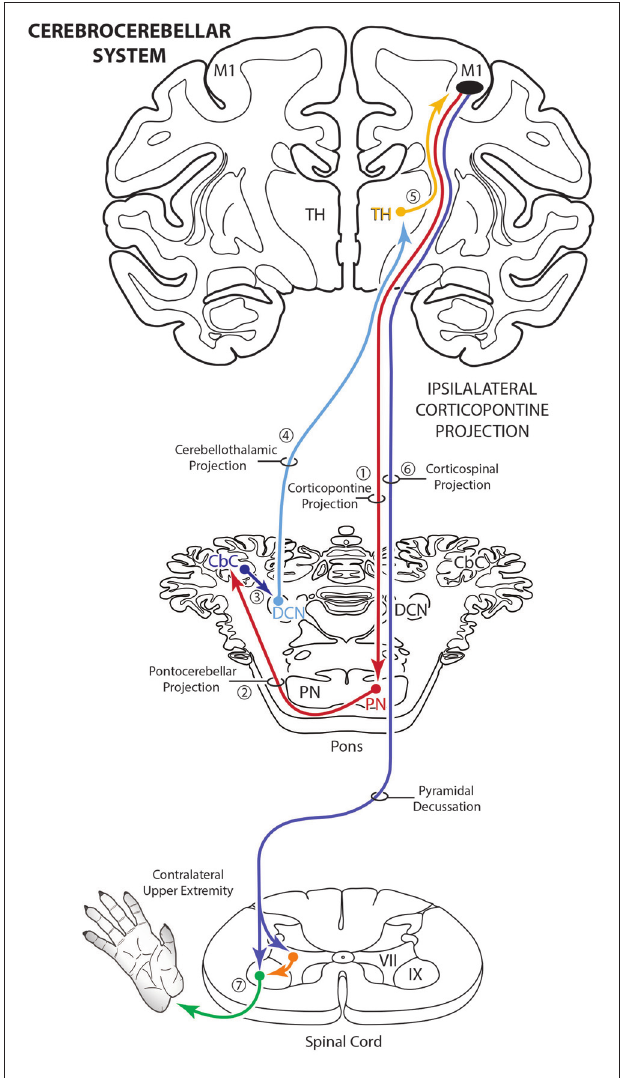
FIGURE 1 | Schematic diagram illustrating the classical cerebrocebellar circuit originating from the primary motor cortex (M1). The sequential stages of the circuit are numbered starting with the powerful descending ipsilateral corticopontine projection (iCPP) to the pontine nuclei (PN) (1). Note that the PN project to the contralateral cerebellar cortex (CbC) (2) and the major cerebellar output from the deep cerebellar nuclei (DCN) ascends to innervate the contralateral thalamus (TH) (4). The thalamus then projects back to the ipsilateral motor cortex (5). The final effect of this cerebrocebellar circuit is on the contralateral upper extremity, via the nearly exclusive contralateral M1 corticospinal projection (CSP) to spinal interneurons (orange) and motoneurons (green) (7). Not illustrated is a small ipsilateral CSP from M1 that represents only 2% of the total terminal bouton CSP with 98% representing the contralateral terminal CSP (Morecraft et al.,